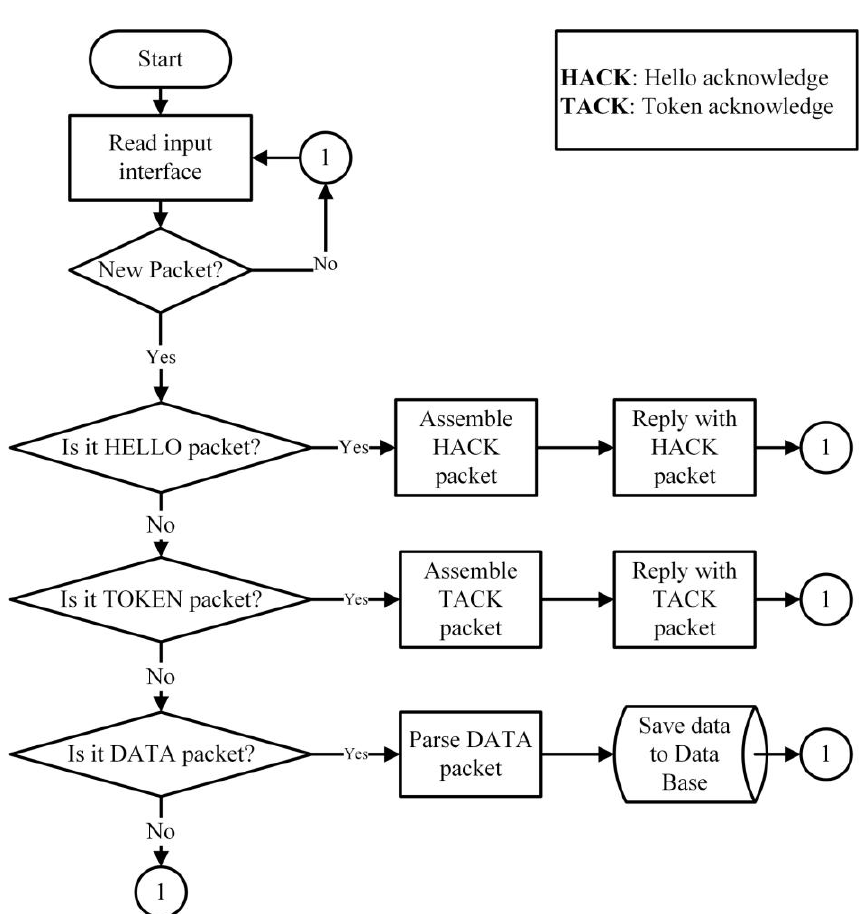
Figure 5. SINK processing